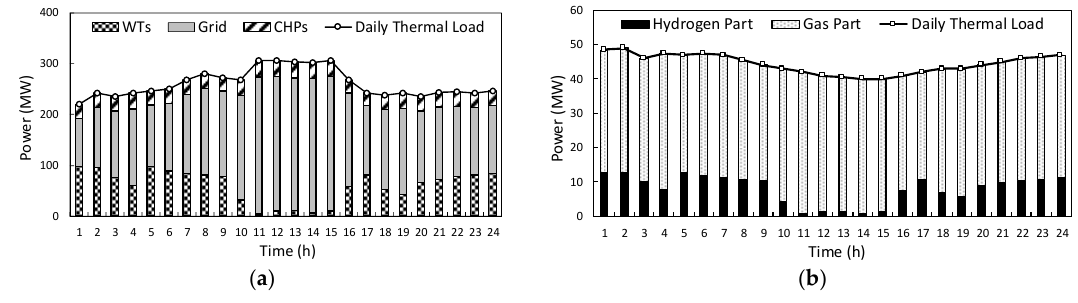
Figure 6. Profiles of Mode 1 with P2G: ( a ) power generation and ( b ) thermal generation.